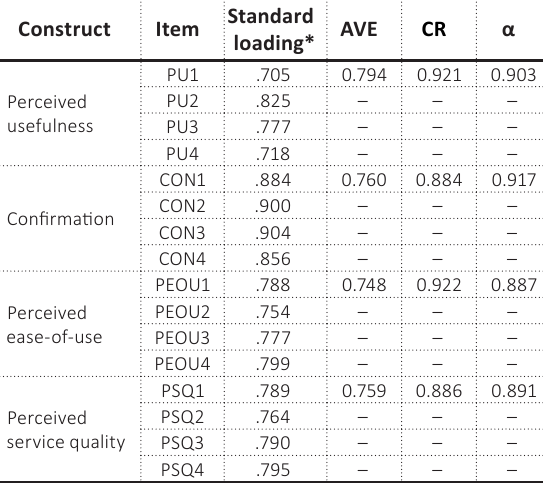
Table 3. Confirmatory factor analysis results